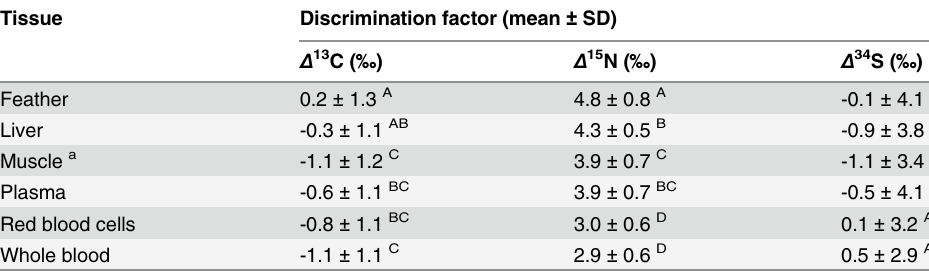
Table 1. Average diet-tissue discrimination factors (mean Δ ± SD of cormorant tissue + catfish diet) for carbon, nitrogen, and sulfur stable isotopes ( Δ 13 C, Δ 15 N, and Δ 34 S) in wild Double-crested Cormo- rants ( Phalacrocorax auritus ) fed a diet of farm-raised catfish in captivity. Tissue types that differed sig- nificantly from one another ( p < 0.05) are indicated by different capital letters after parentheses within each column (ANOVA with post-hoc Tukey Kramer